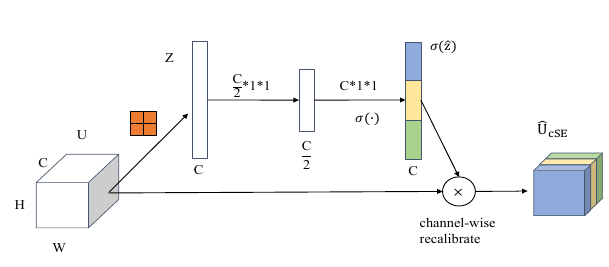
Figure 5. The structure of cSE.